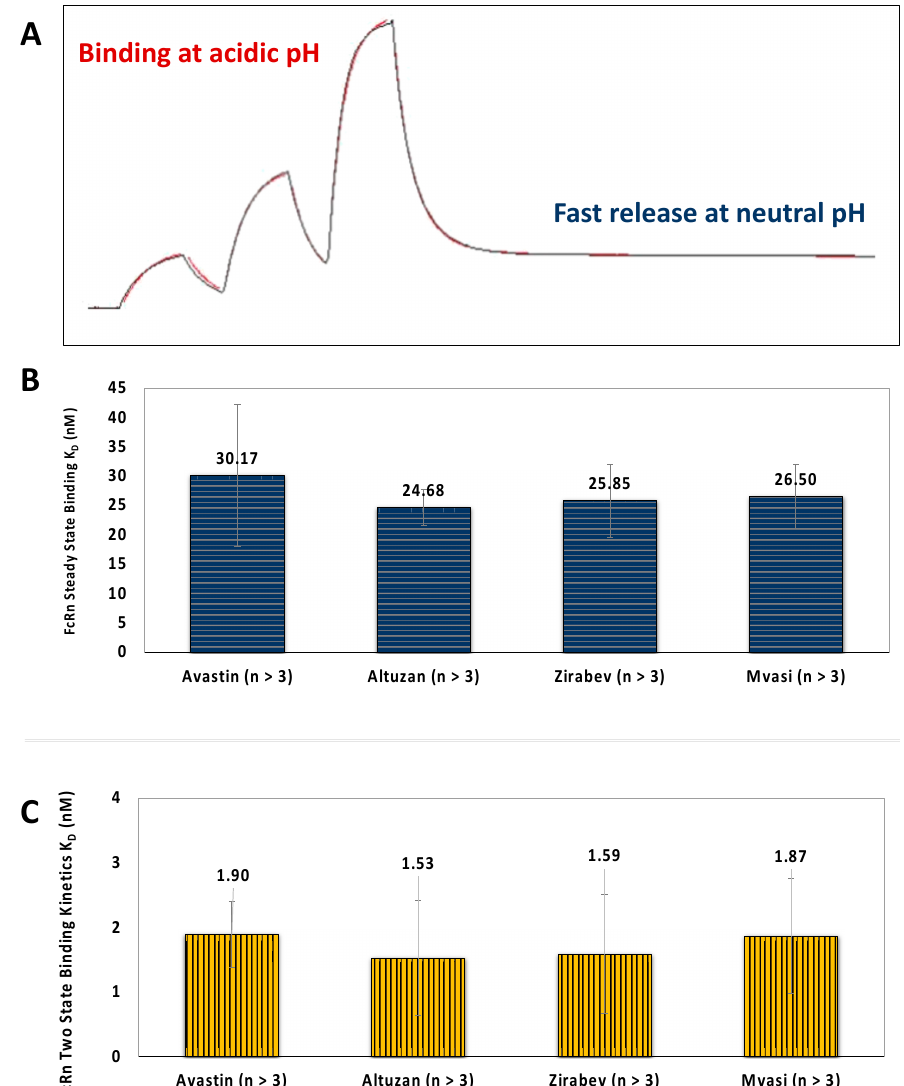
Figure 6. FcRn binding analysis of the samples ( A ) Typical sensograms for an injected mAb sample and immobilized FcRn were shown. FcRn captures mAb molecules at acidic pH and releases them when the pH becomes neutral. ( B ) Steady-state interaction of bevacizumab-based mAb-based samples with immobilized FcRn molecules was represented as the mean of at least three measurements. ( B ) Langmuir 1:1 binding model based SPR results for VEGF binding. The data represented the mean of at least three independent measurements. ( C ) Two-state binding interaction of bevacizumab-based mAb-based samples with immobilized FcRn molecules was represented as the mean of at least three measurements. There was no significant difference between Avastin, and other samples based on the Single-way ANOVA analysis ( p <